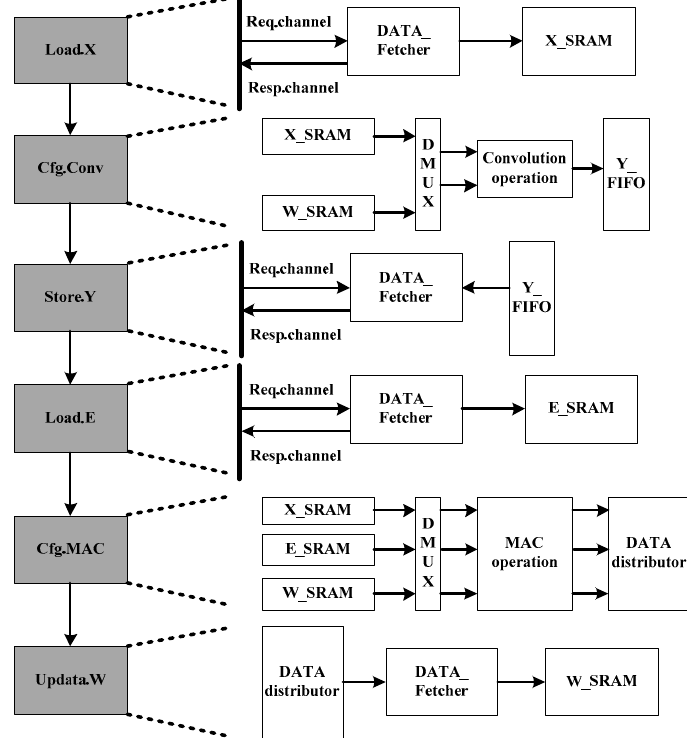
Figure 9. Usage flow and hardware operation of custom instruction.